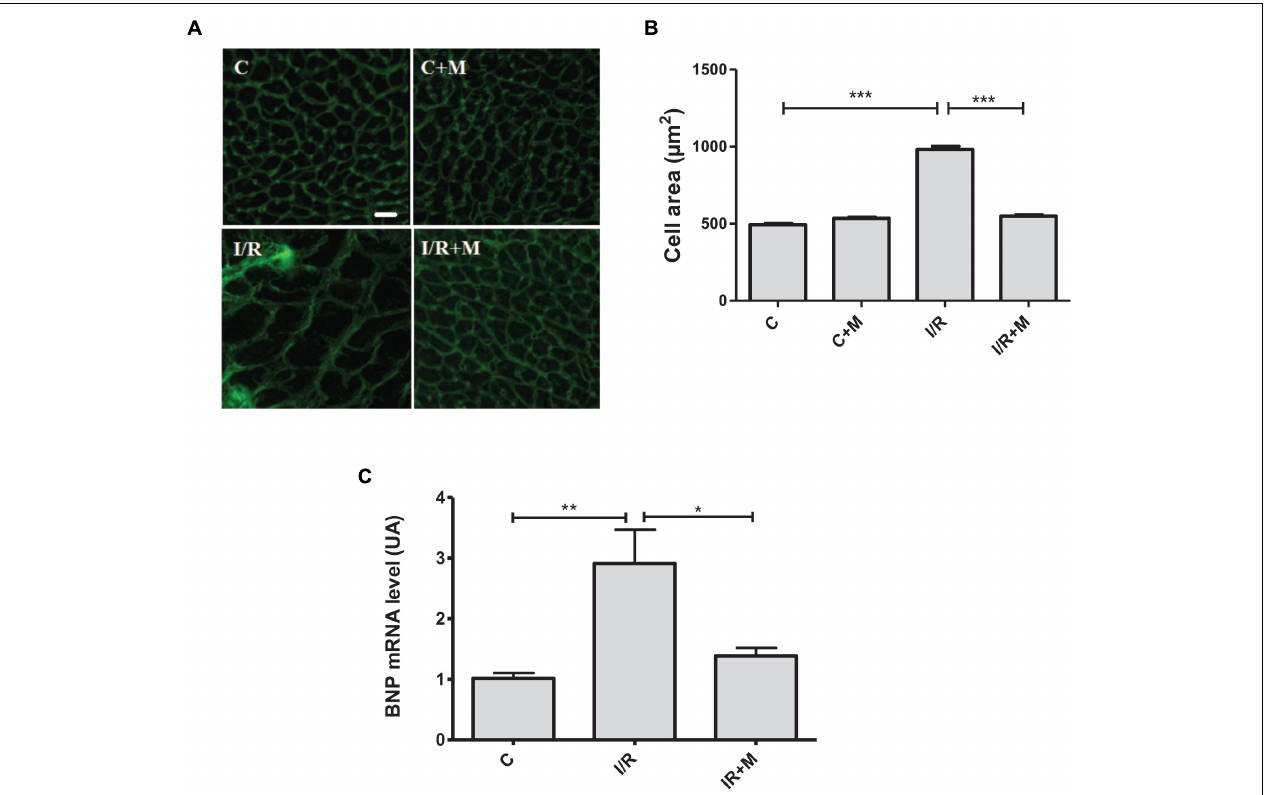
FIGURE 7 | Metformin treatment reduces cardiac hypertrophy in I/R-challenged hearts. (A) Representative images of wheat germ agglutinin (WGA) staining of heart frozen tissue sections. Mice were subjected to 30 min of cardiac ischemia and 14 days of reperfusion. Metformin treatment (5 mg/kg/day, i.p.) started at 15 min of post-reperfusion and continued for 14 days. Scale bar is 25 µ M. (B) . Quantification of cell size from (A) . (C) . qRT-PCR analysis of the expression level of the hypertrophic marker BNP. Data are presented as mean ± SEM. Statistical analysis was carried out by one-way ANOVA: ∗ P < 0.05, ∗∗ P < 0.01, ∗∗∗ P < 0.001 between indicated conditions.